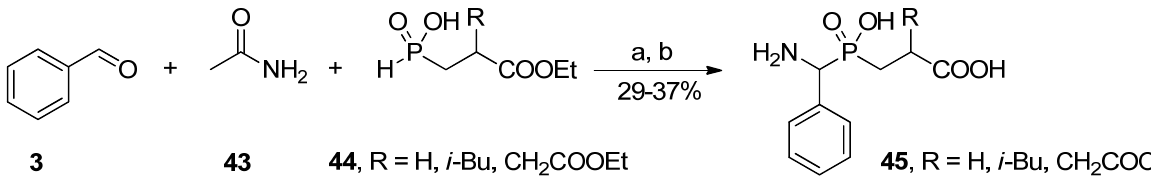
Scheme 12. Synthesis of deprotected phosphinic dipeptides in a three-component condensation of benzaldehyde, acetamide, and 2-substituted 2-ethoxycarbonylethyl- H - phosphinic acid.